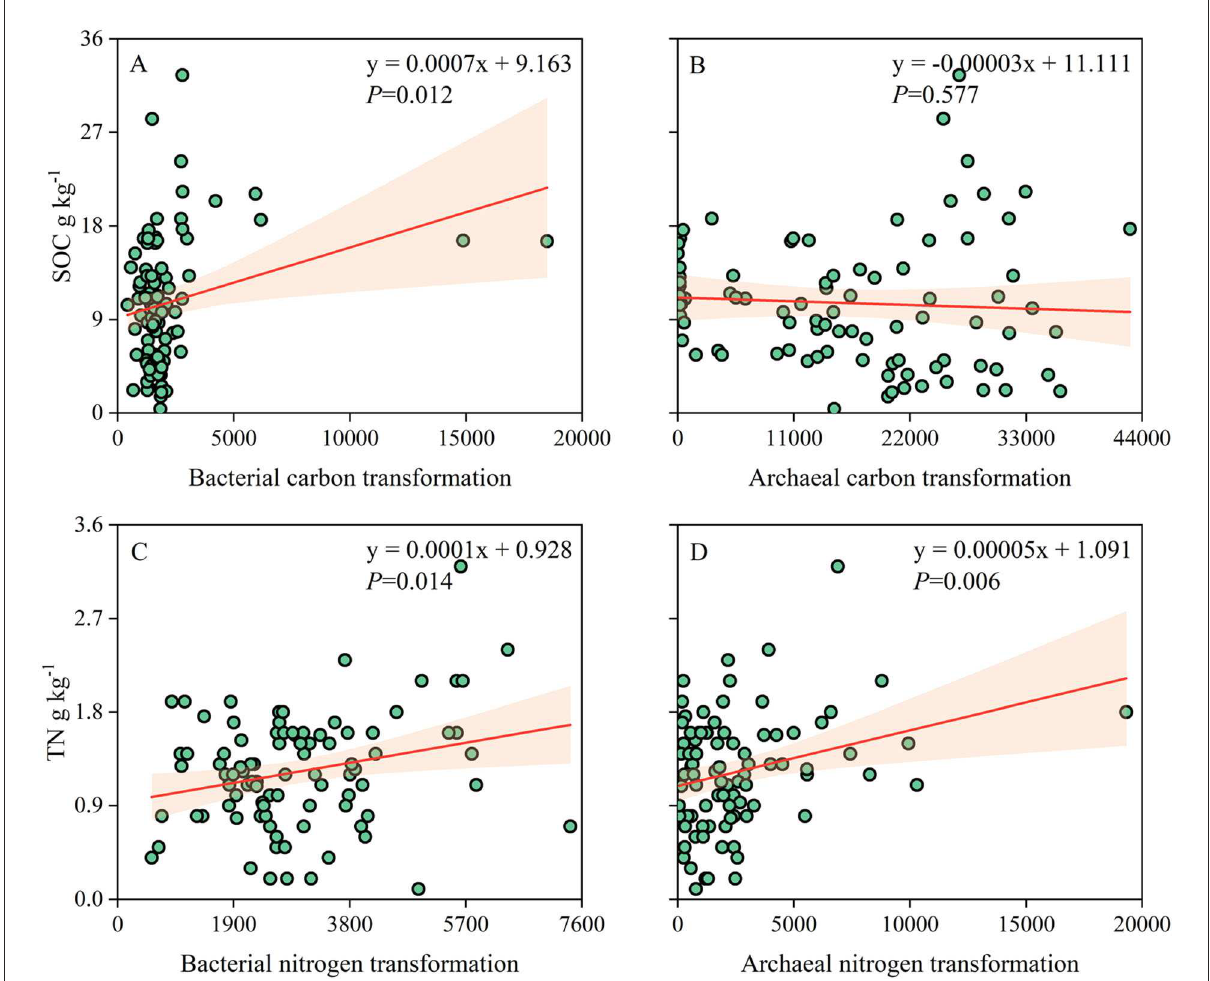
FIGURE7 (A–D) Relationships of soil prokaryotic community carbon and nitrogen transformations with SOC and TN